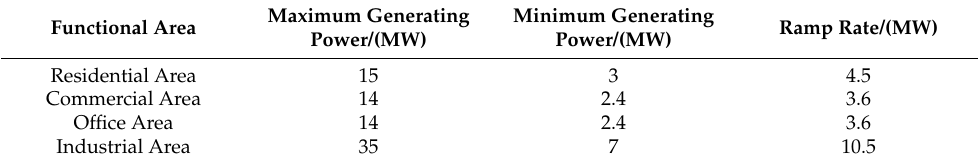
Table 2. The parameters of CHP in different functional areas. Functional